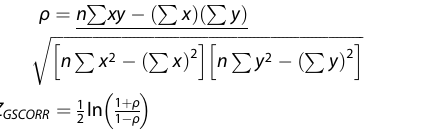
This equation is implemented in R 4.1.2 with custom script to calculate GSCORR values. Global signal topography — ROI selection In addition to the prede fi ned regions of the three layers of self [7], we also used a different anatomical template to de fi ne the relevant regions in a